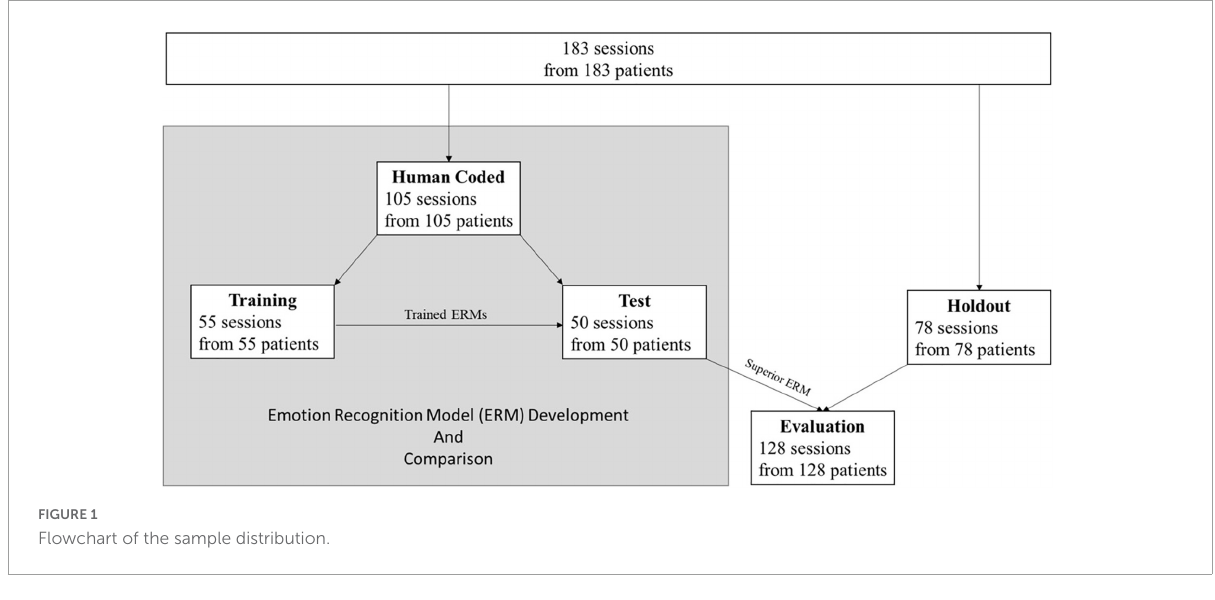
TABLE 1 Sample characteristics of the training, test, and evaluation